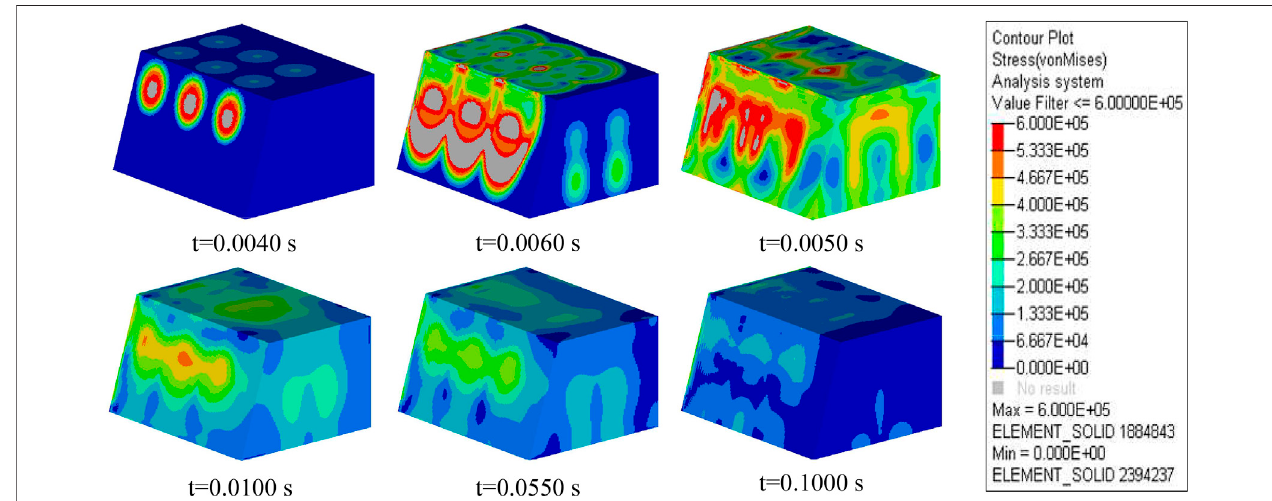
FIGURE 9 | Cloud diagram of spaced loading blasting stress distribution.